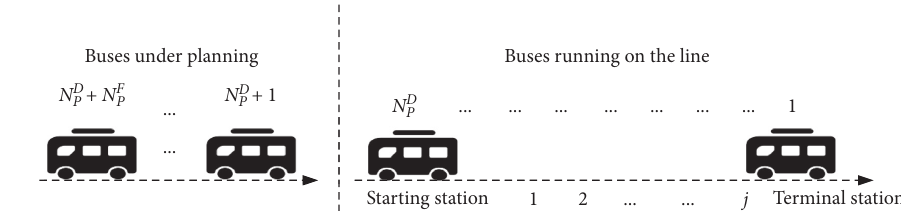
Figure 1: Bus departure operation diagram of a single